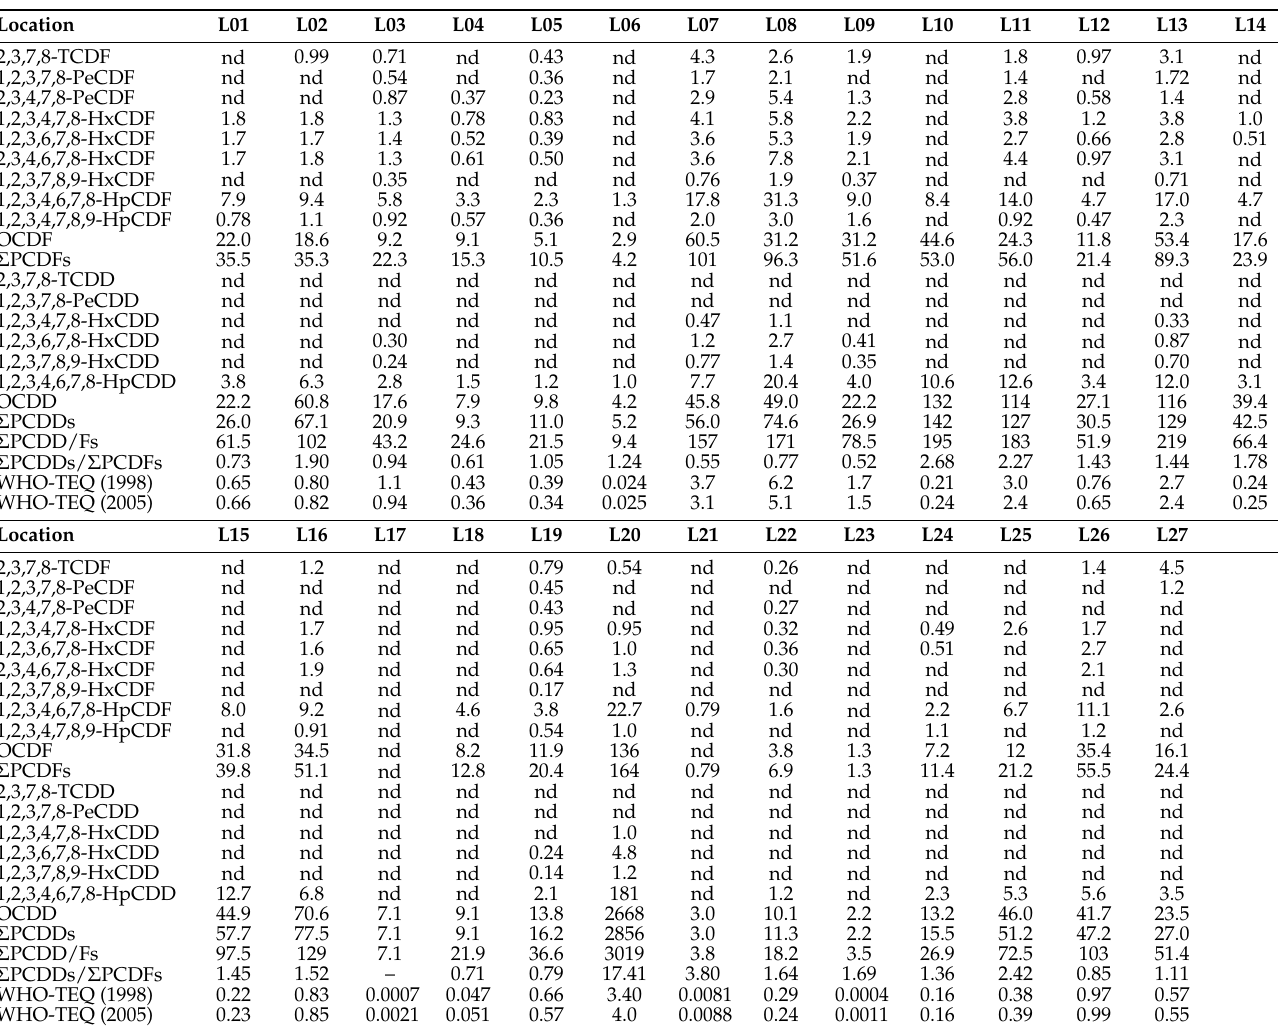
Table 1. Concentrations (pg g − 1 dw) of PCDD/Fs in the surface sediments from